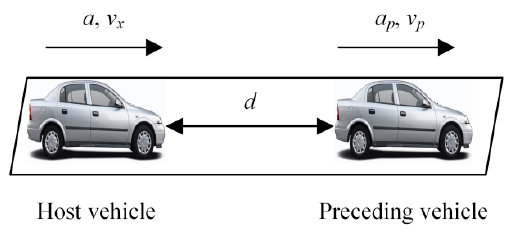
Figure 4. Vehicle following model.